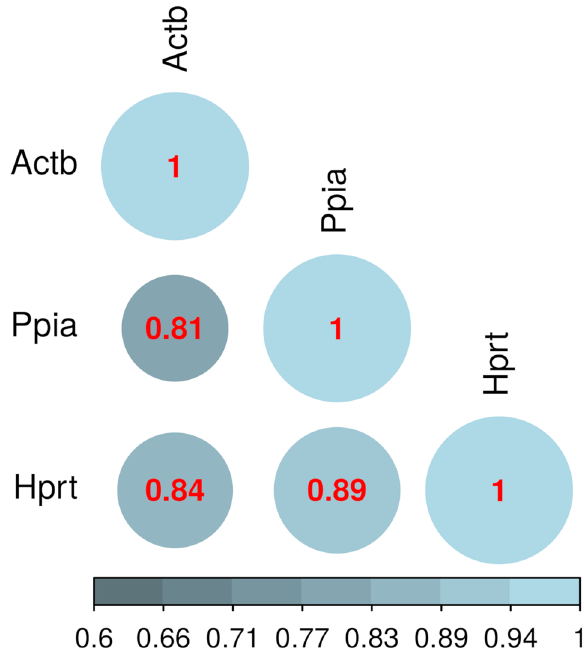
Figure 5. Pair correlation matrix between the number of amplification cycles of the best housekeeping candidate genes Actb, Hprt and Ppia . Circle color and radius are proportional to the Spearman’s rank correlation coefficient (significance level: p ≤